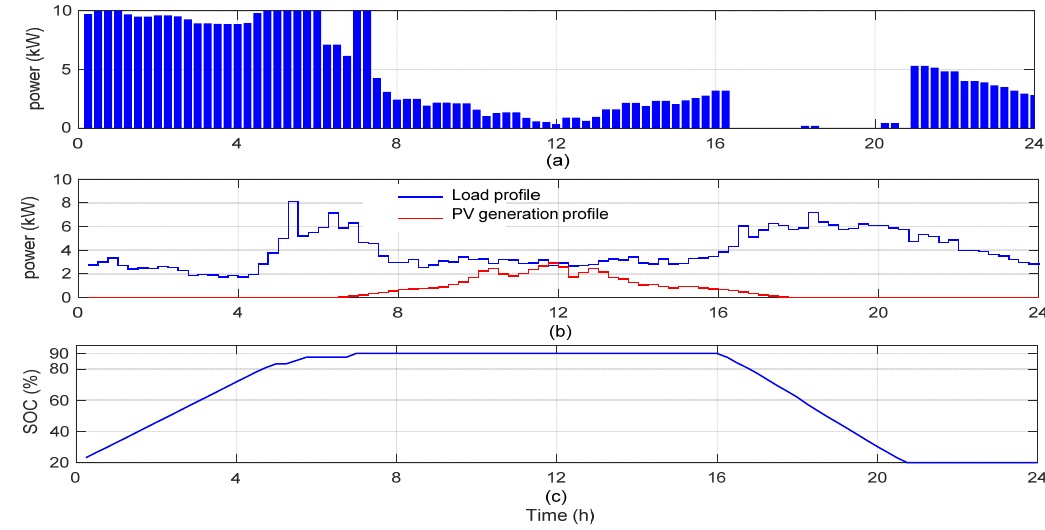
Figure 9. ( a ) Reference values for the power drawn by the MG from the main grid for autumn; ( b ) MG’s forecasted load and PV generation profiles; ( c ) Resultant state of charge curve of the BESS.